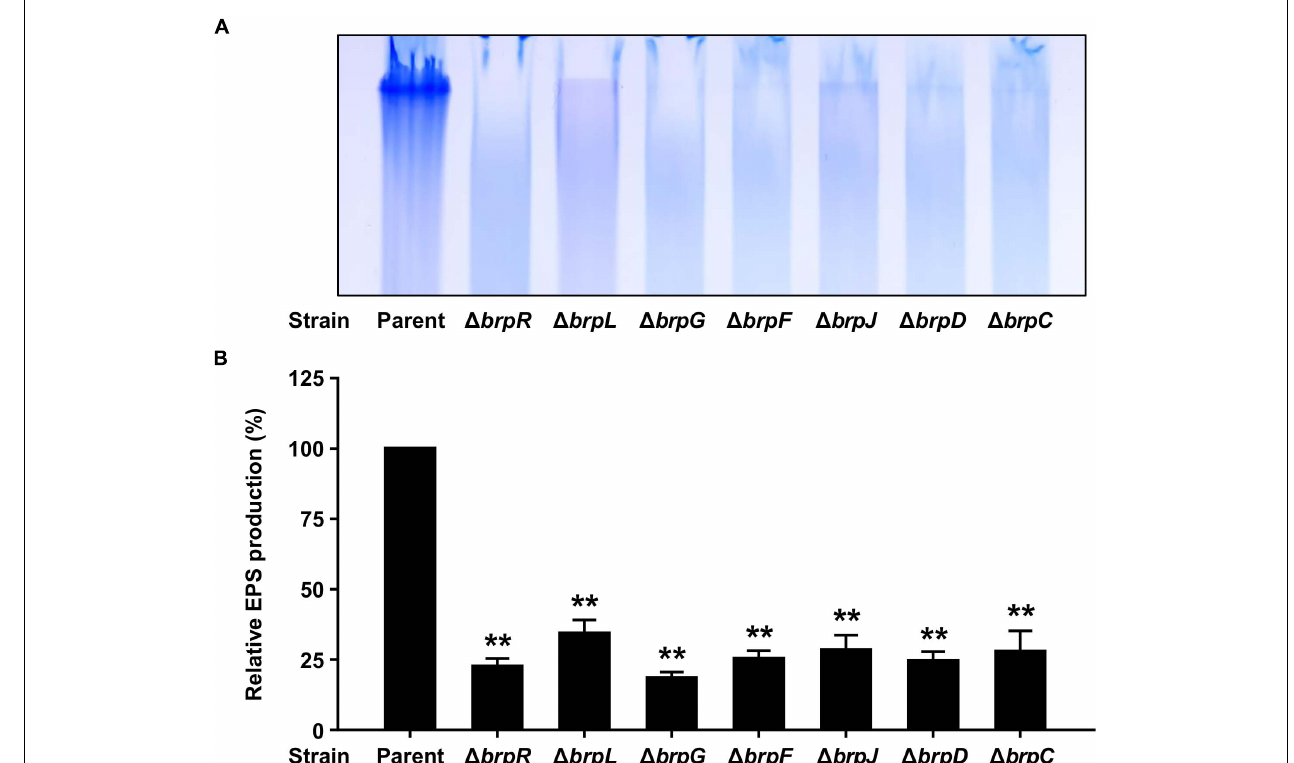
FIGURE 8 | EPS production impaired by the deletion of brpLG and the brp locus genes. (A) EPS extracts were prepared from the parent and mutant strains and resolved on a 4% polyacrylamide gel by SDS-PAGE. The gel was stained with Stains-All and photographed. (B) EPS production was quantified from the intensity of each lane, and the production of the parent strain was set at 100% in each experiment. Average and SD of the intensity values from three independent experiments were represented. Error bars represent the SD. Statistical significance was determined by the Student’s t test (**, P < 0.005 relative to the parent